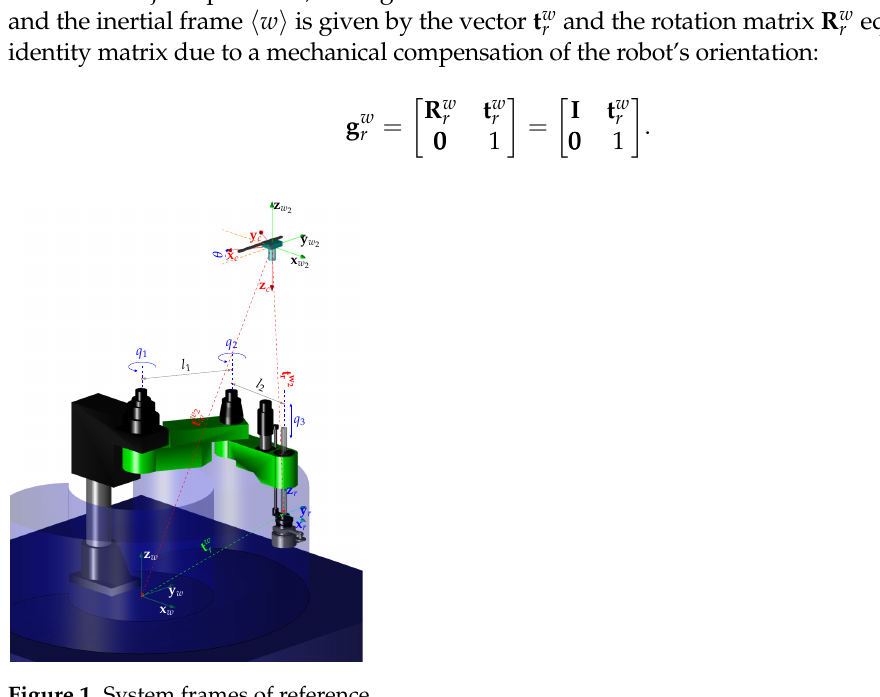
Figure 1. System frames of